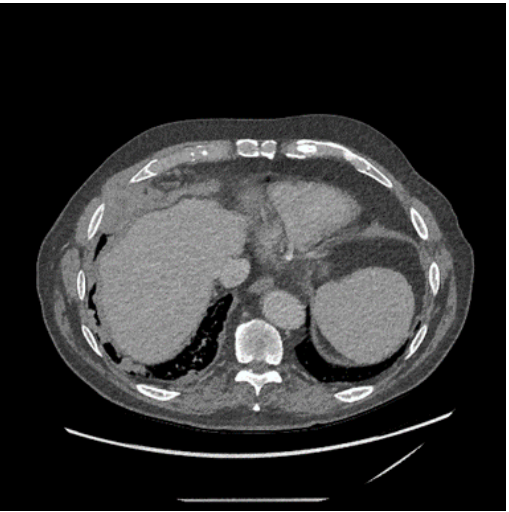
Figure 3. Non-contrast enhanced computed tomography of the chest in a 79-year-old man involved in the mining of crocidolite demonstrating nodular thickening of the pleura in the right base. Image guided fine need aspiration confirmed the presence of epithelioid mesothelioma.